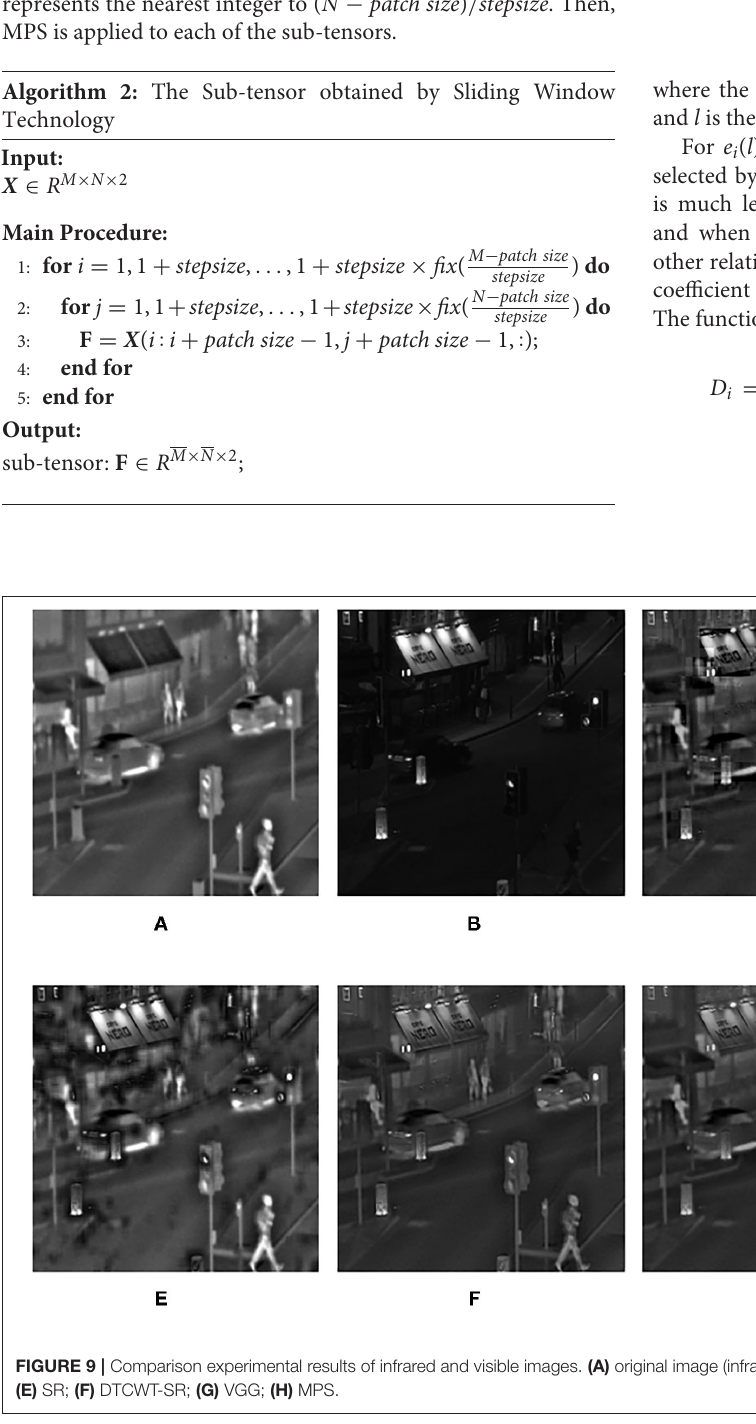
Frontiers in Neurorobotics |